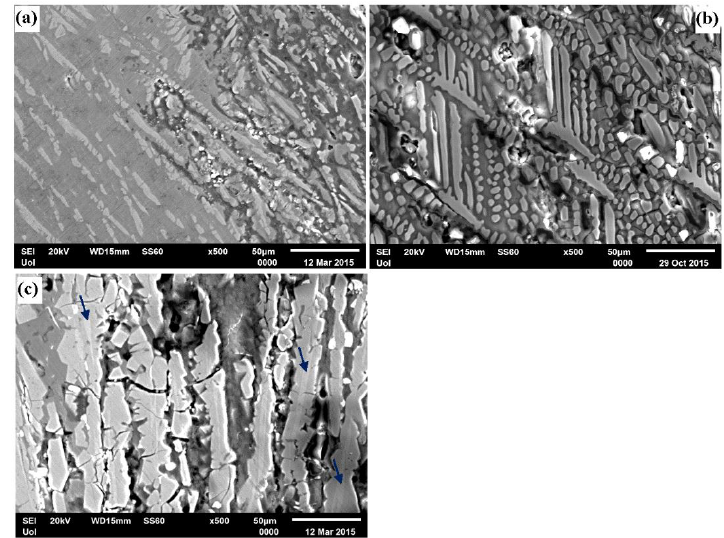
Figure 6. Cross sections (SE mode) of ( a ) Al‐7 wt.% Co, ( b ) Al‐15 wt.% Co and ( c ) Al‐20 wt.% Co after cyclic polarization (3.5 wt.% NaCl, 25 °C); the blue arrows in Figure 6c point at the Al 13 Co 4 phase.